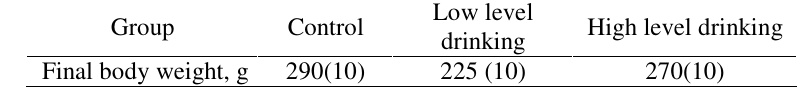
Table 1. Body weights over 60 days for rats in different groups (values are mean for a number of observations in parentheses)